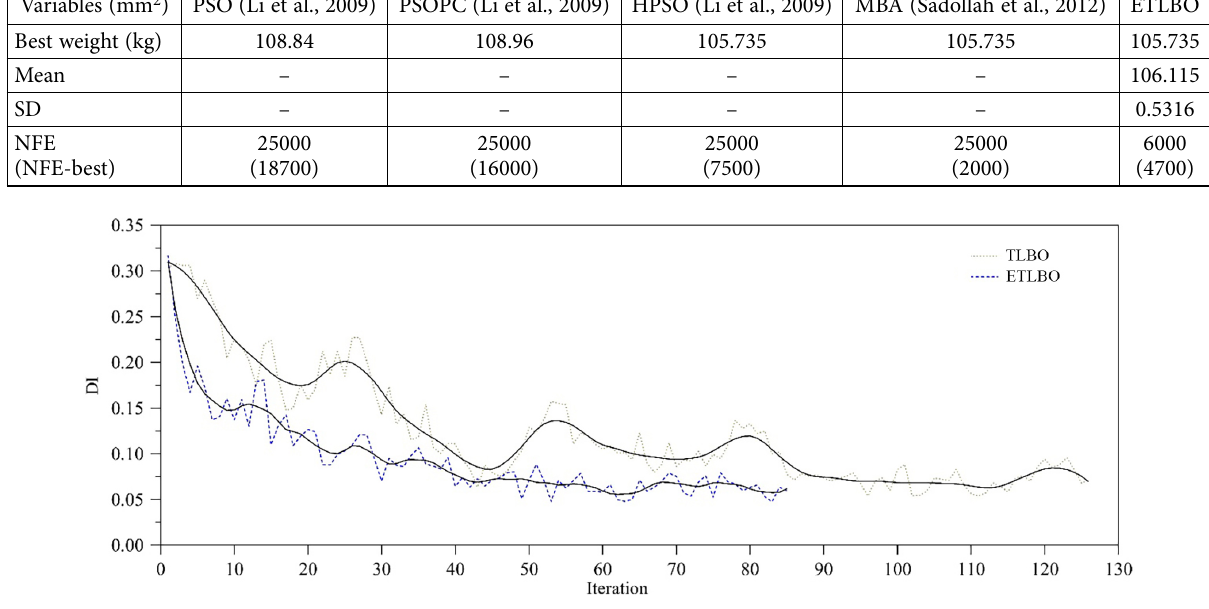
Figure 7. DI traces of ETLBO vs. TLBO for the 15-bar truss